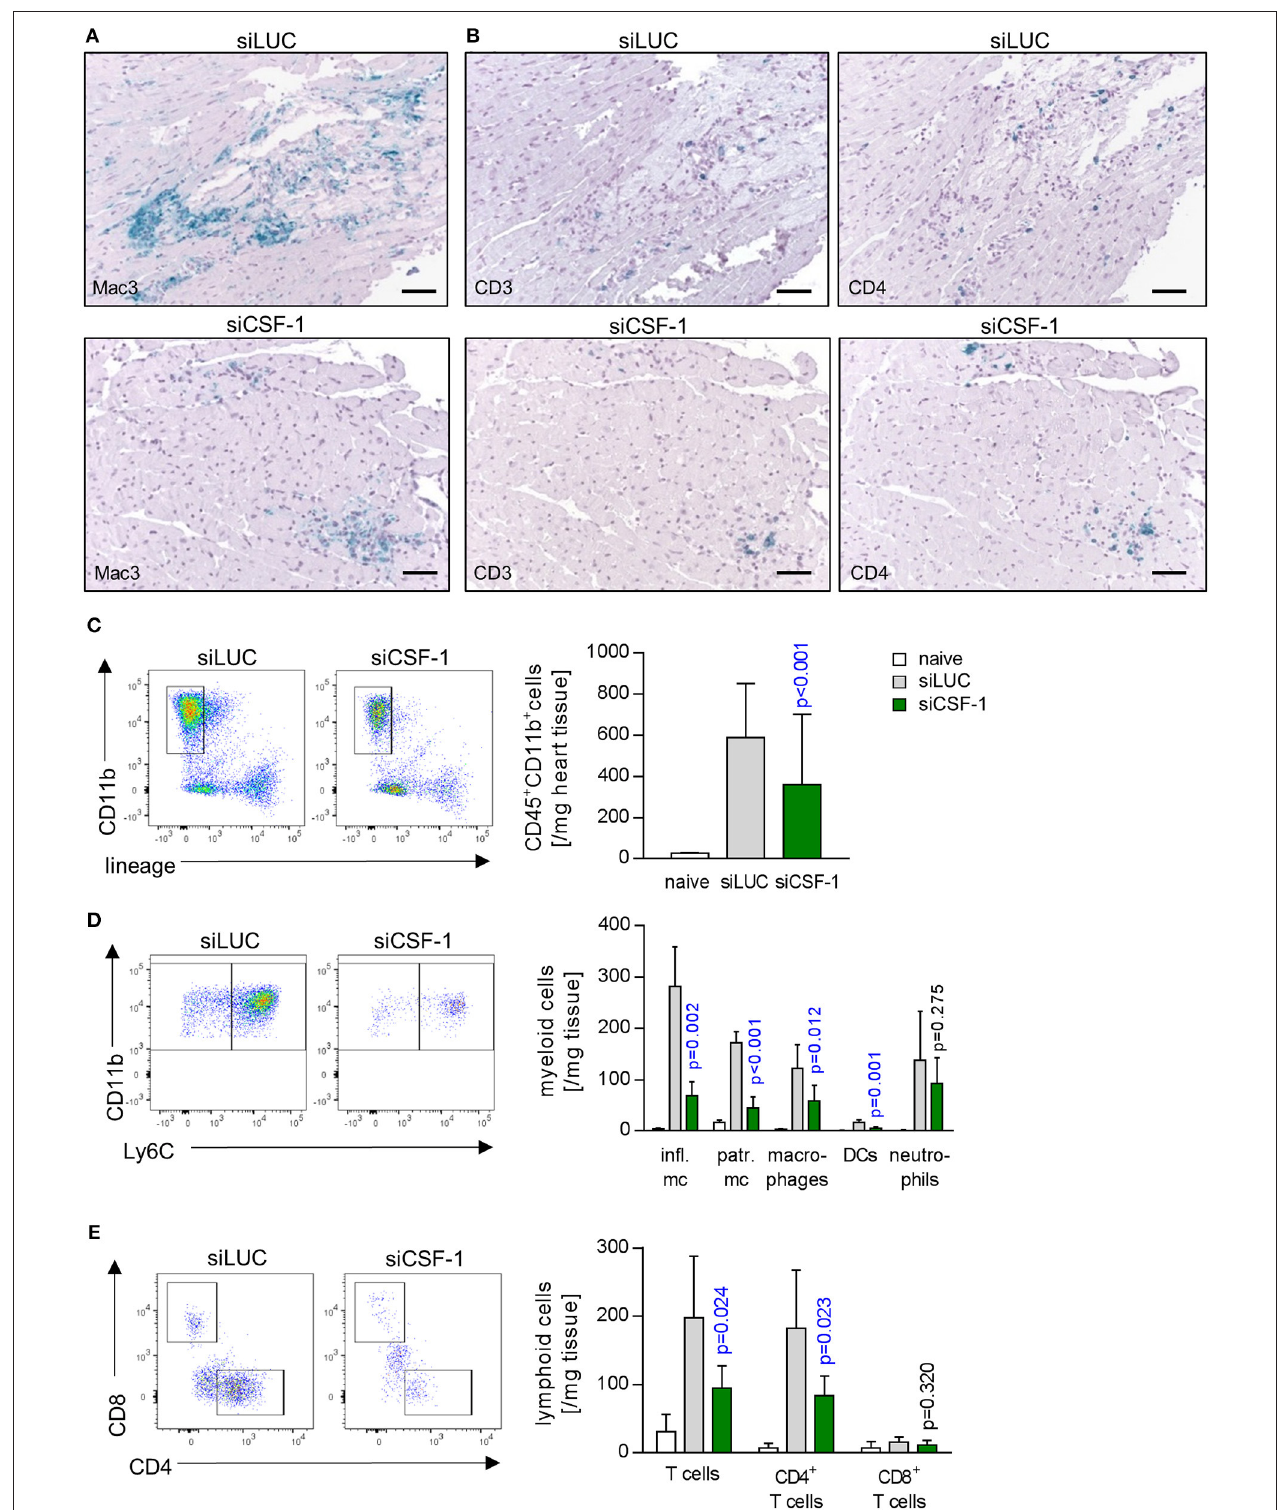
FIGURE 5 | Influence of CSF-1 on immune cell infiltration into heart tissue during AVM. To further differentiate immune cell infiltration, immunohistochemical stain for (A) mononuclear phagocytes using antibodies directed against Mac-3 and (B) T-cells using antibodies directed against CD3 and CD4 were performed